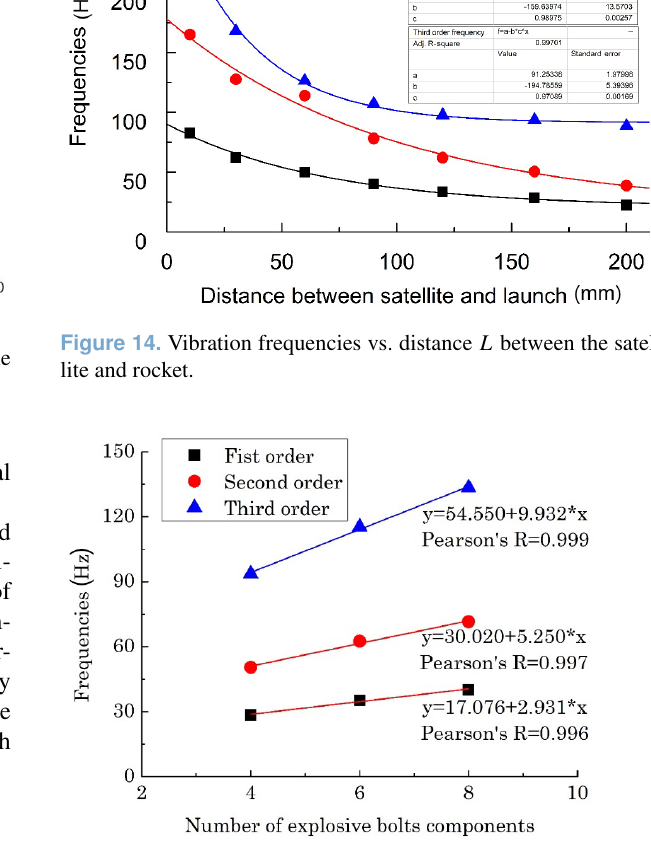
Figure 15. Vibration frequencies of the satellite with varying num- bers of explosive bolts and MR